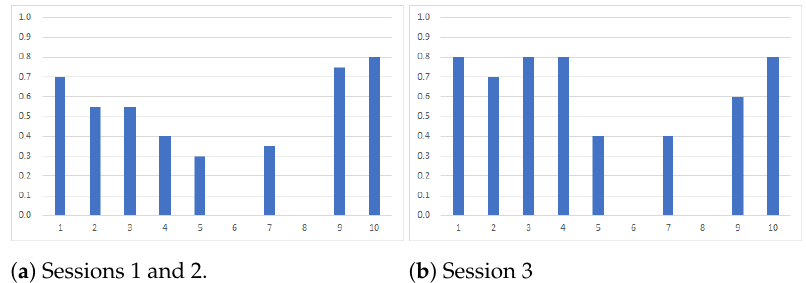
Figure 3. Frequency of reaching the NE Outcome in